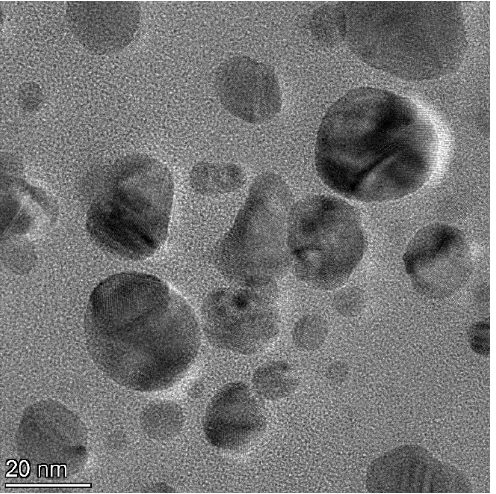
Figure 4. TEM analysis for the synthesized silver nanoparticles.